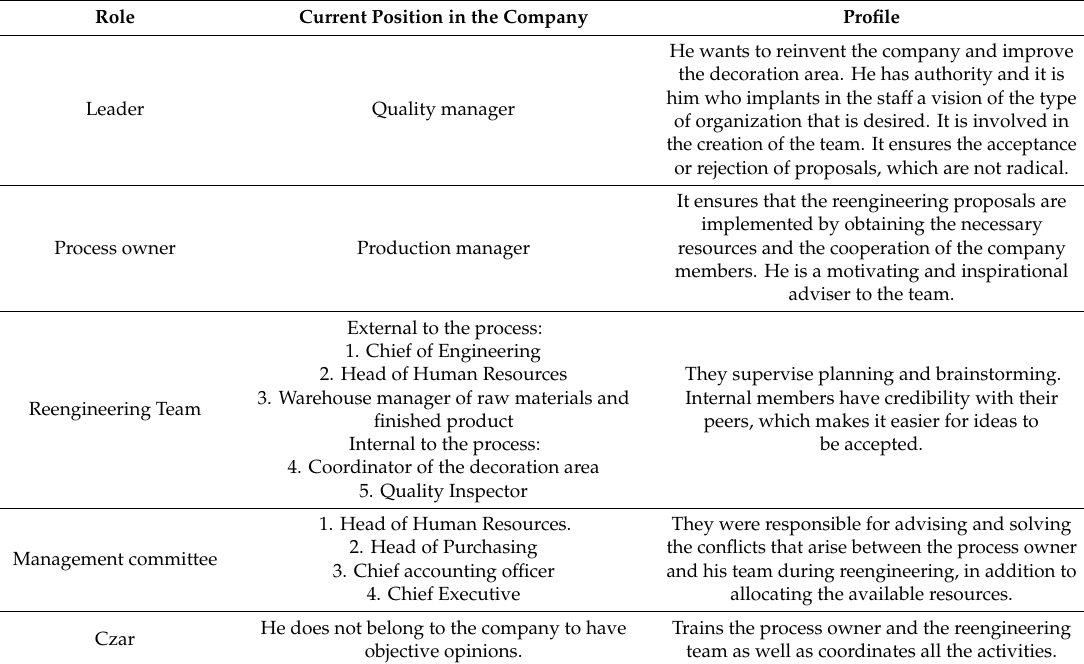
Table 1. Selection of the members of the reengineering